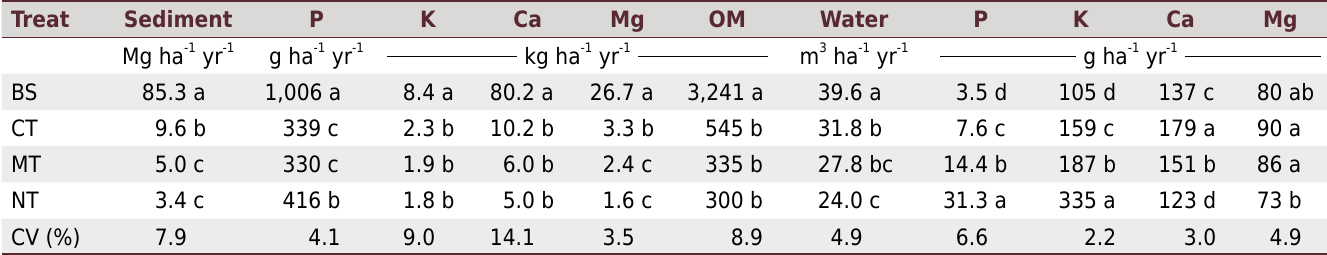
Table 3. Total annual losses of sediments and water, of extractable phosphorus (P), potassium (K), calcium (Ca), and magnesium (Mg), of exchangeable organic matter (OM) in the sediments, and of P, K, Ca, and Mg soluble in water from water erosion, under natural rainfall in the different treatments (Treat) in a Humic Cambisol (average of 15 years)